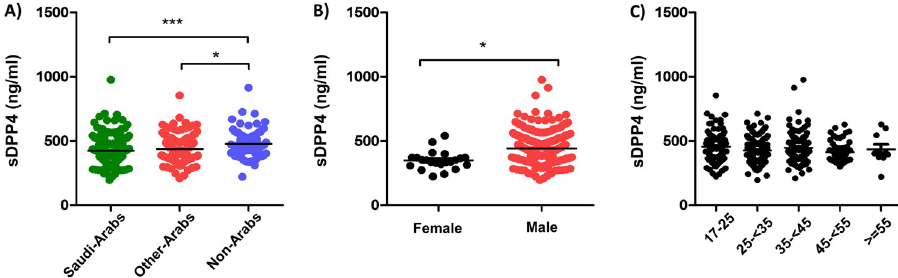
Fig 2. Average sDPP4 level among the study population according to (A) ethnicity, (B) Gender, and (C) age group.